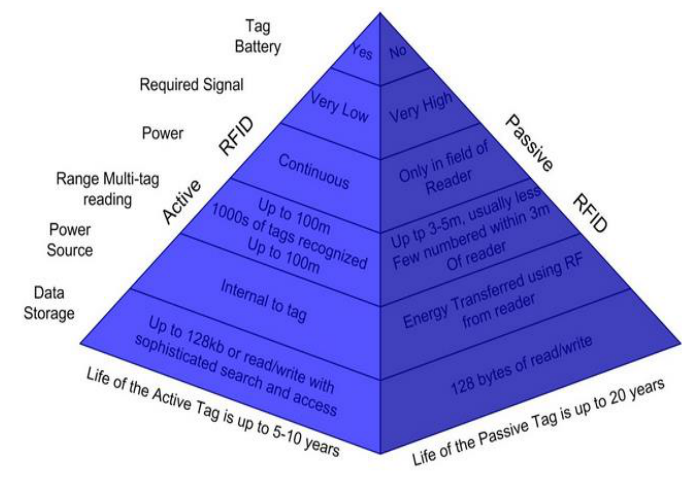
Fig. 2. A comparison of RFID active and passive tags [10].